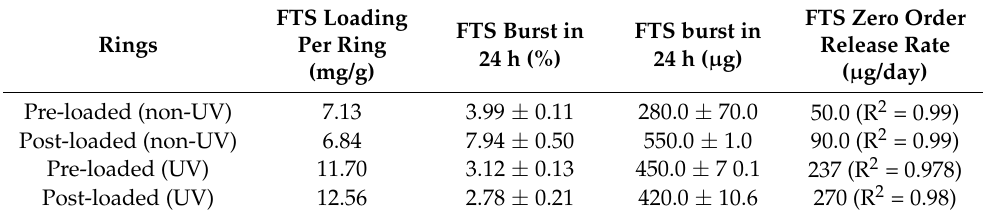
Table 6. Total amount of FTS in rings normalized to the weights of rings (n = 3), release rate of FTS at zero order kinetics ( µ